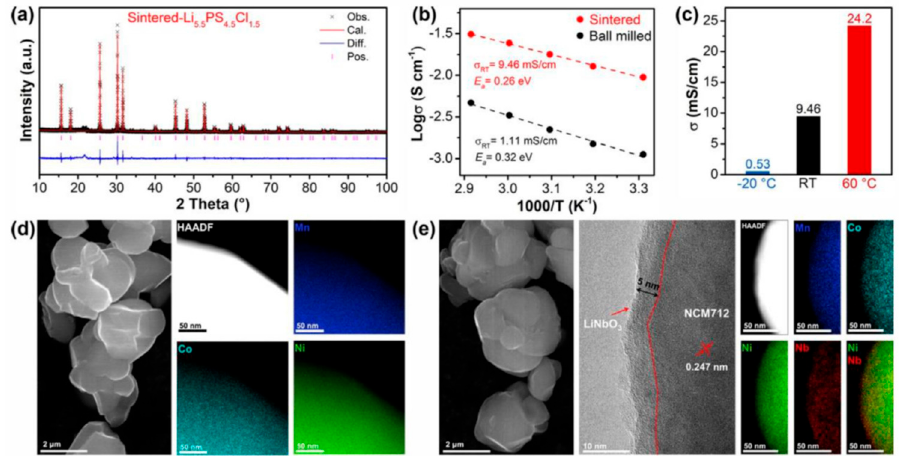
Figure 9. Characterizations of LiNbO 3 -coated LiNi 0.7 Co 0.1 Mn 0.2 O 2 (LNO@NCM712) [70]. ( a )